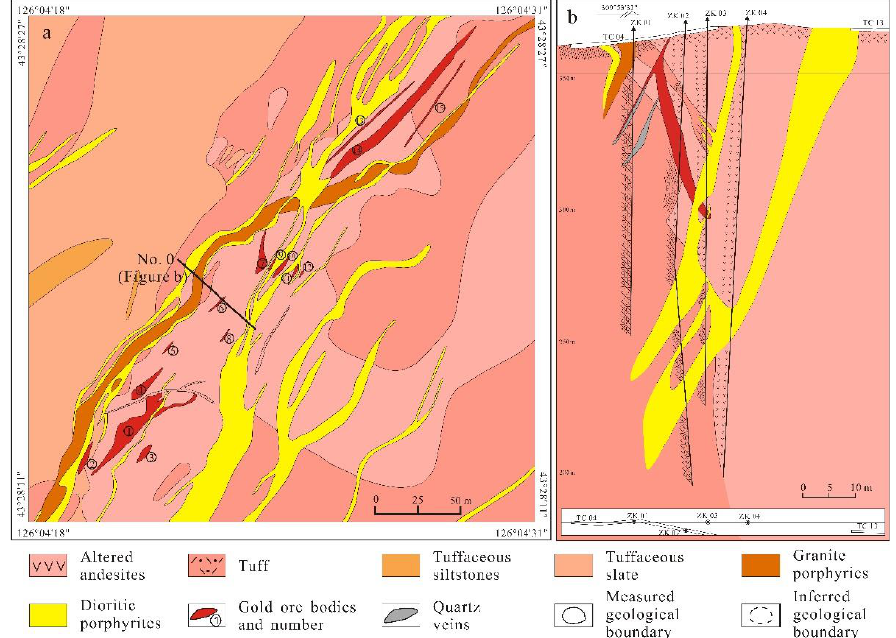
Figure 2. ( a ) Geologic map of the Toudaochuan deposit. ( b ) Geologic profile of Toudaochuan exploration line No. 0 (after JBGMR [44]).